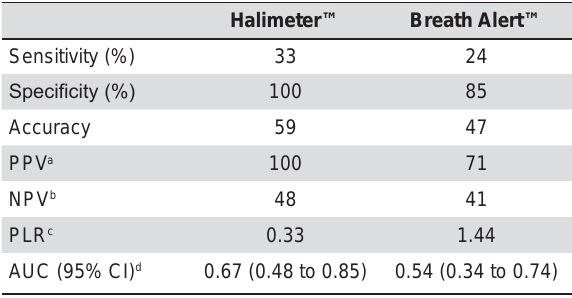
Table 1- Diagnostic results of Breath Alert™ and Halimeter™ tests